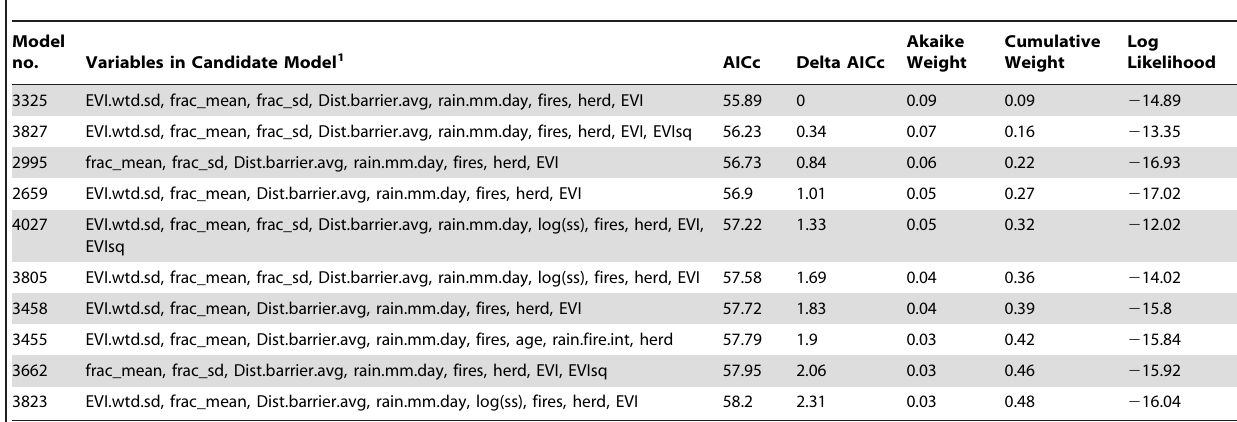
Table 3. Characteristics of ten best models explaining buffalo migration (dependent variable =Net Squared Displacement) in the Caprivi Strip of